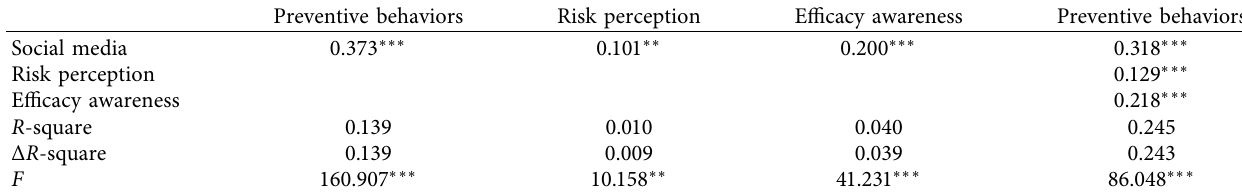
Table 13: Mediating efect test (social media information